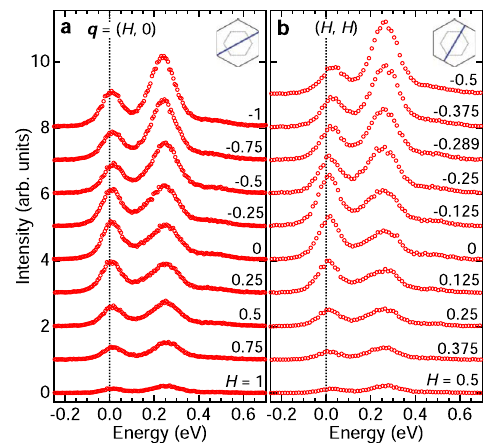
Fig. 3 Momentum dependence of low-energy RIXS spectra. a , b Low- energy Ru L 3 RIXS spectra at T = 20 K along the q = ( H , 0) and ( H , H ) directions. The insets show the measurement paths in the q